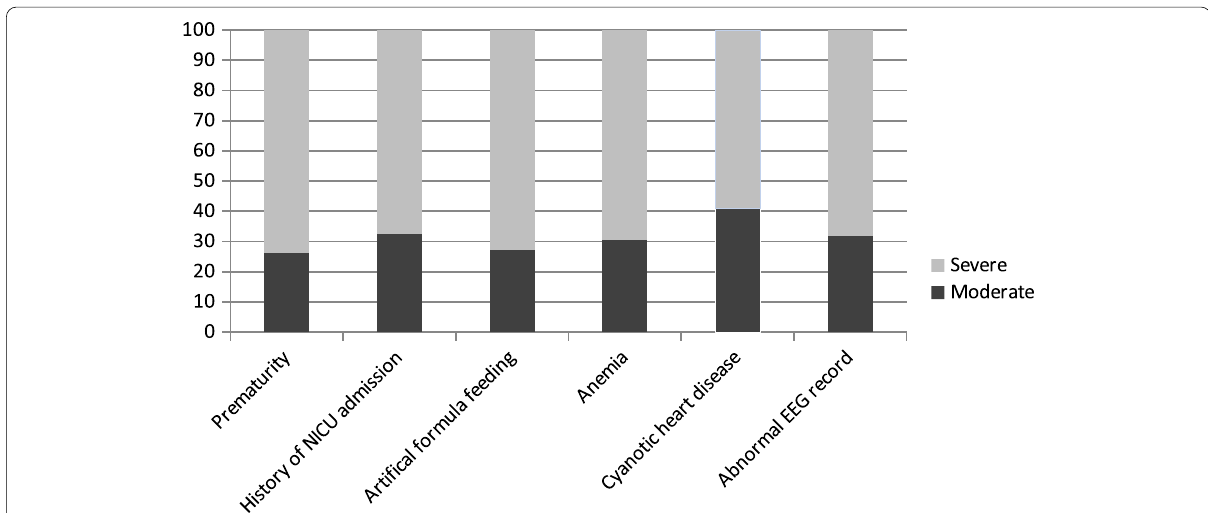
Fig. 1 Relation between potential risk factors and severity of developmental delay